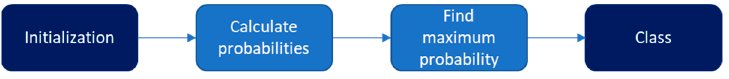
Figure 1. Indicative example of BNB steps.